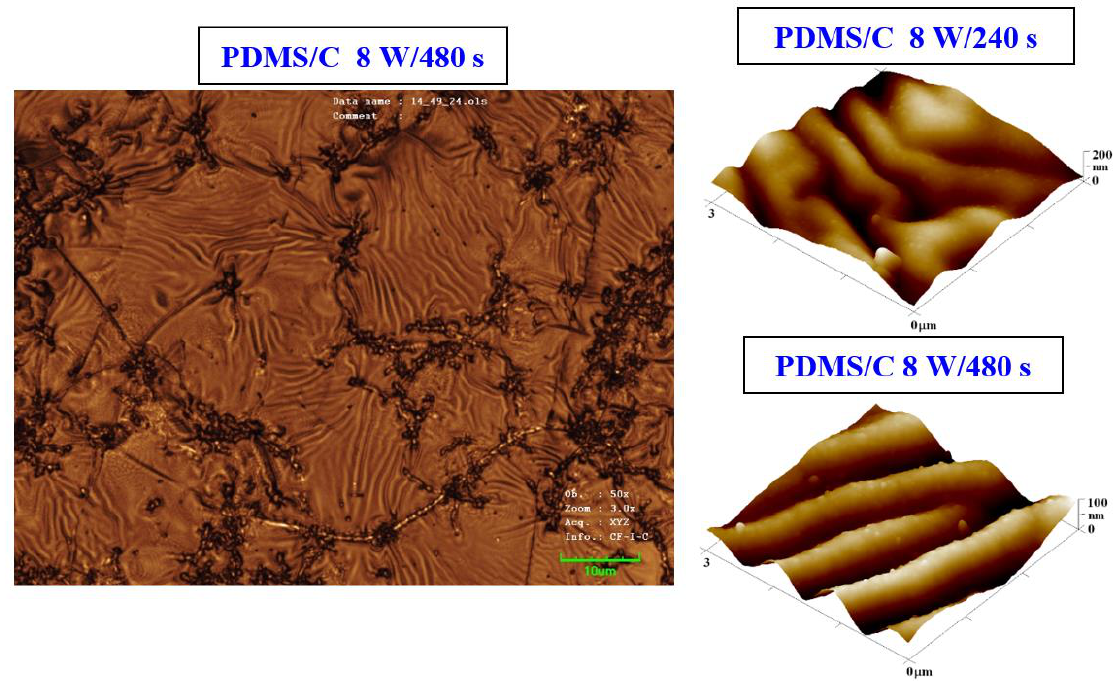
Figure 3. Image of the surface of a PDMS/C foil (2 wt.% of C) after plasma modification (8 W, 480 s) and thermal stress (1 h, 100 °C) taken by a confocal microscope with a displayed area of 85 × 64 μm 2 (left image). AFM images of plasma-modified and thermally stressed (1 h, 100 °C) composite films C (PDMS/C 2 wt.%); the sample was modified by 8 W for 240 s (R a = 27.7 nm) and by 8 W for 480 s (R a = 18.1 nm).